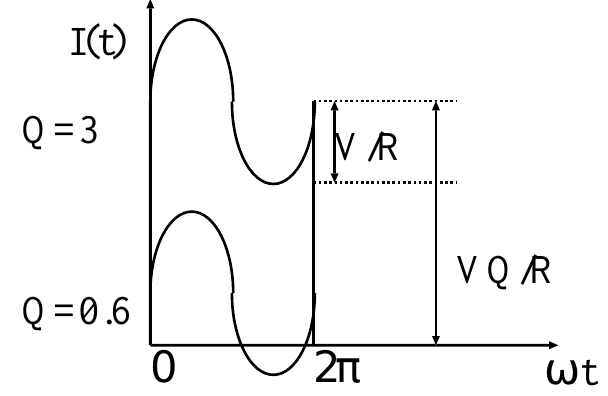
FIG. 2. Necessary peak currents for a barrier. The values of V (cid:1) R are fixed at 10.